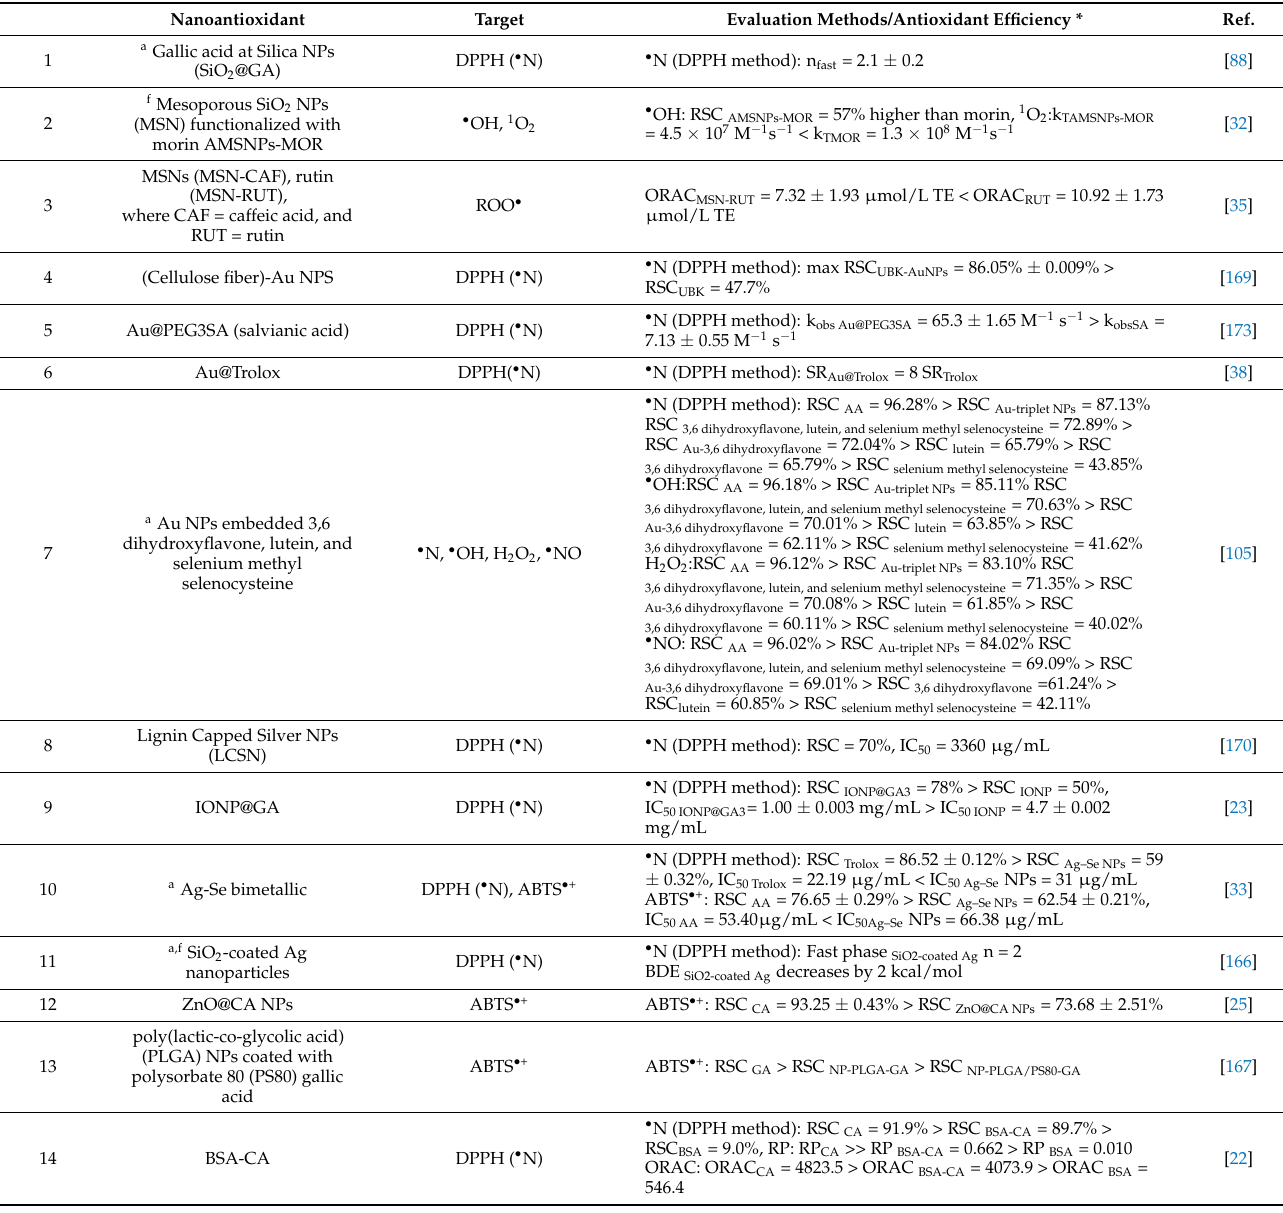
Table 4. List of engineered hybrid nanoantioxidants developed through grafting of natural antioxi- dants or functional